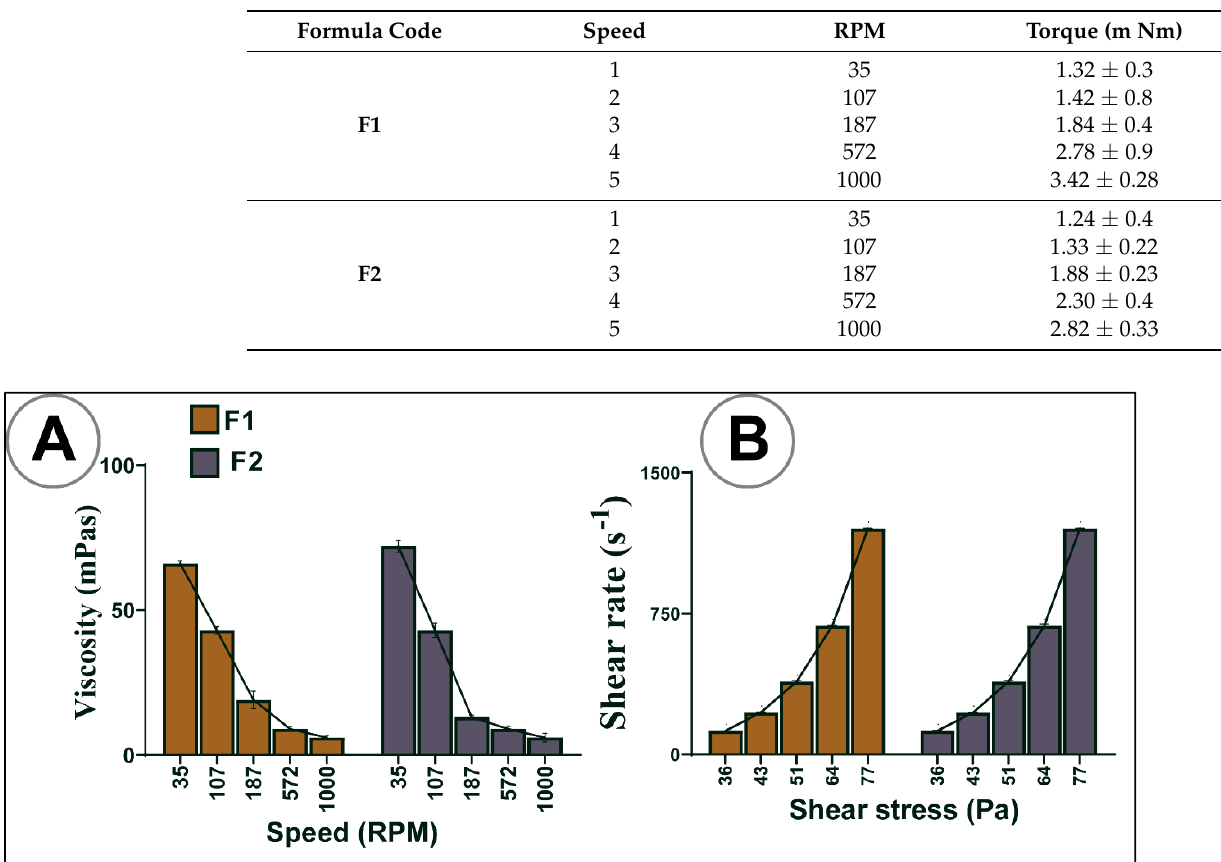
Table 1. Zeta potential, particle size analysis, and Fourier transform infrared. N = 3, mean ± SD. Table 2. Rheological parameter measurement before microencapsulation at various mixing speeds: N = 3, mean ± SD. Formulation